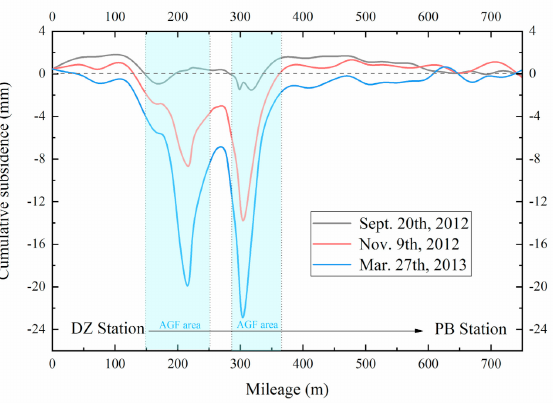
Figure 1. Uneven cumulative subsidence after artificial ground freezing (AGF) subway construction. The areas in blue show the regions where AGF construction areas overlap.